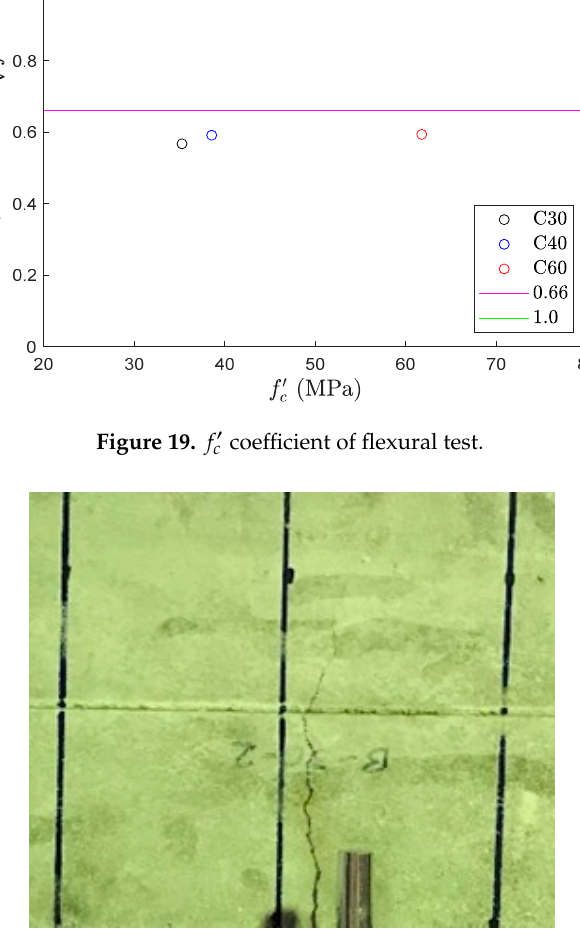
Figure 20. Zoom view of failure mode in flexural test.